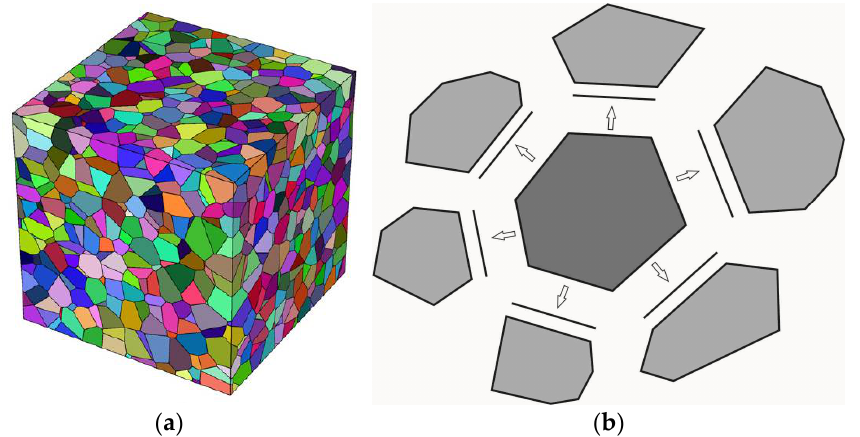
Figure 3. Polyhedral representation of polycrystal grains ( a ) and scheme of the grain structure in the statistical model ( b ). statistical model ( b